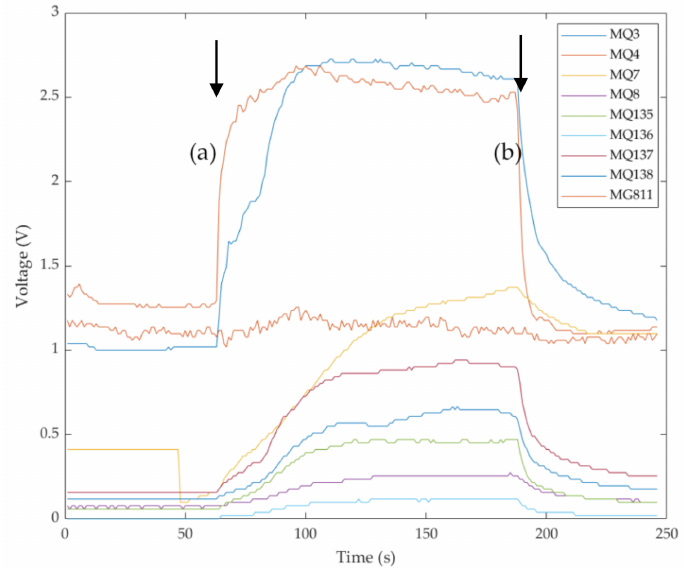
Figure 1. Data extraction from e-nose outputs using a supervised customized code written in Matlab. Initial ( a ) and final ( b ) stable signal detection and automatic subdivision in ten equidistant sampling intervals to obtain ten